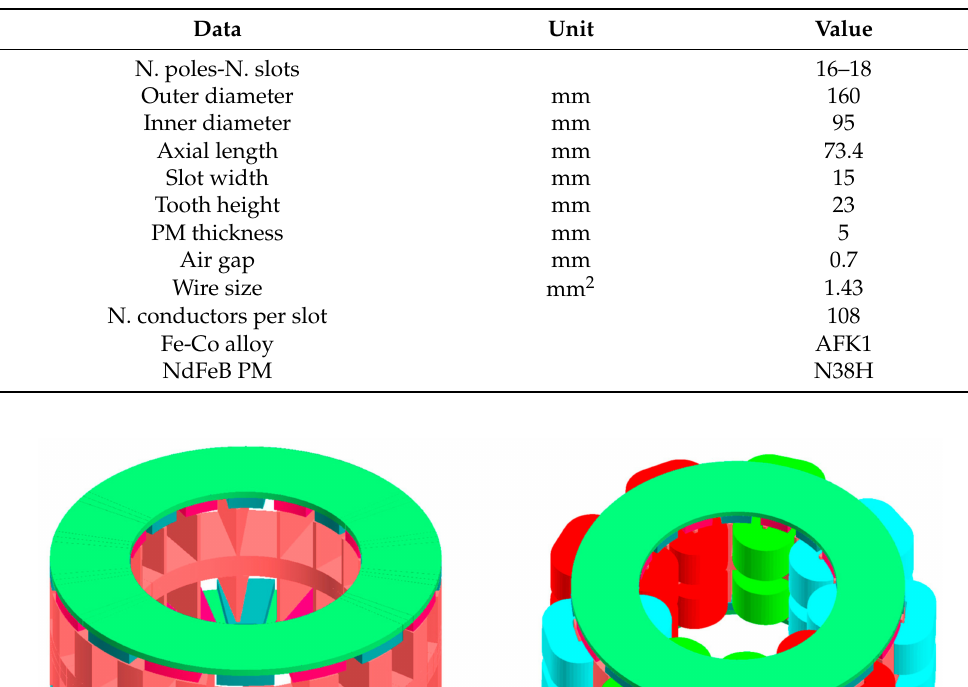
Table 2. Main data of the double-sided AFPM motor.